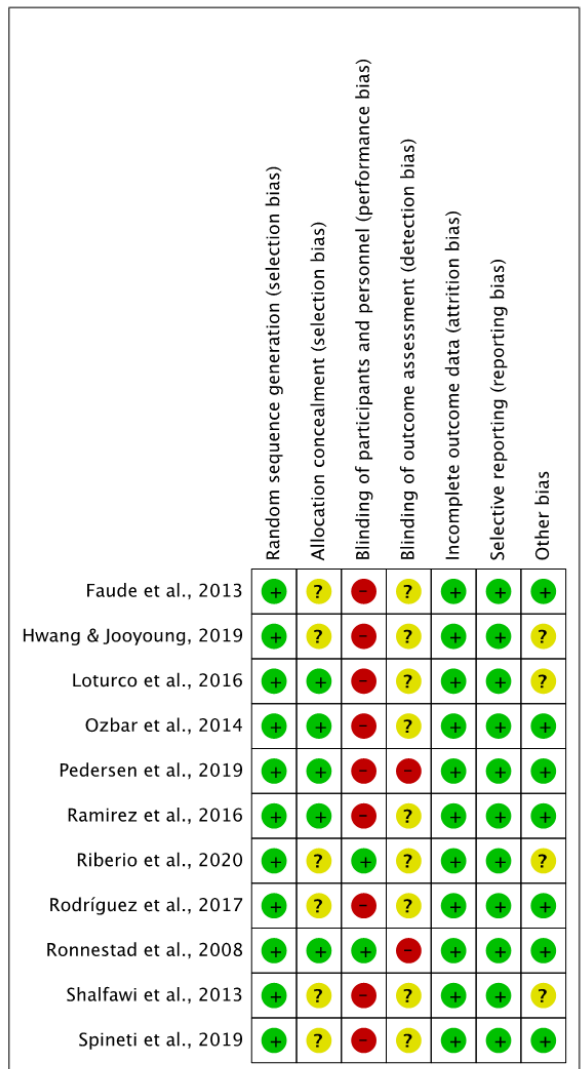
Figure 2. Risk of bias graph.